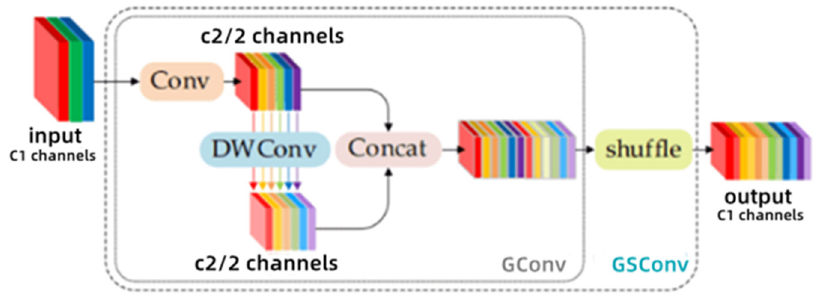
Figure 9. GSConv structure diagram.